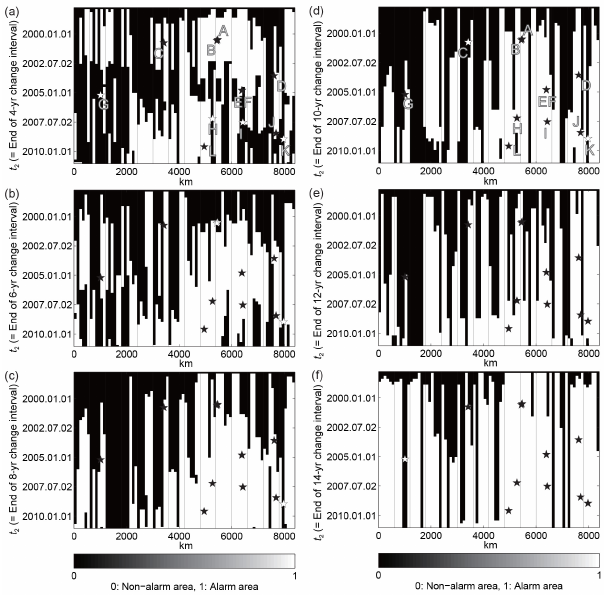
Fig. 6. Spatiotemporal distribution of the alarm area for a cutoff magnitude of 3.5. The alarm area is defined as the total spatiotem- poral area occupied by the prediction periods that follow the change intervals with large seismicity changes, or with the common loga- rithm of PI values higher than − 0.4. The black and white stars cor- respond to the red and white stars in Figs. 3–5, respectively. White grid cells correspond to the alarm area; black grid cells show the nonalarm area, which is defined as the complement of the alarm area. The vertical black lines and horizontal and vertical axes are as in Fig. 3. The labels (A)–(L) correspond to the earthquake indices in Table 1.